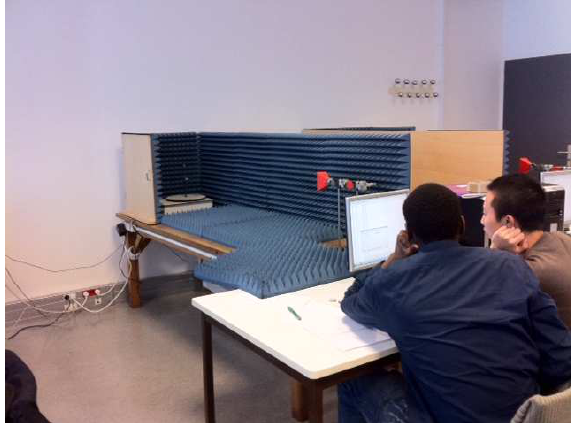
Figure 1: measurements